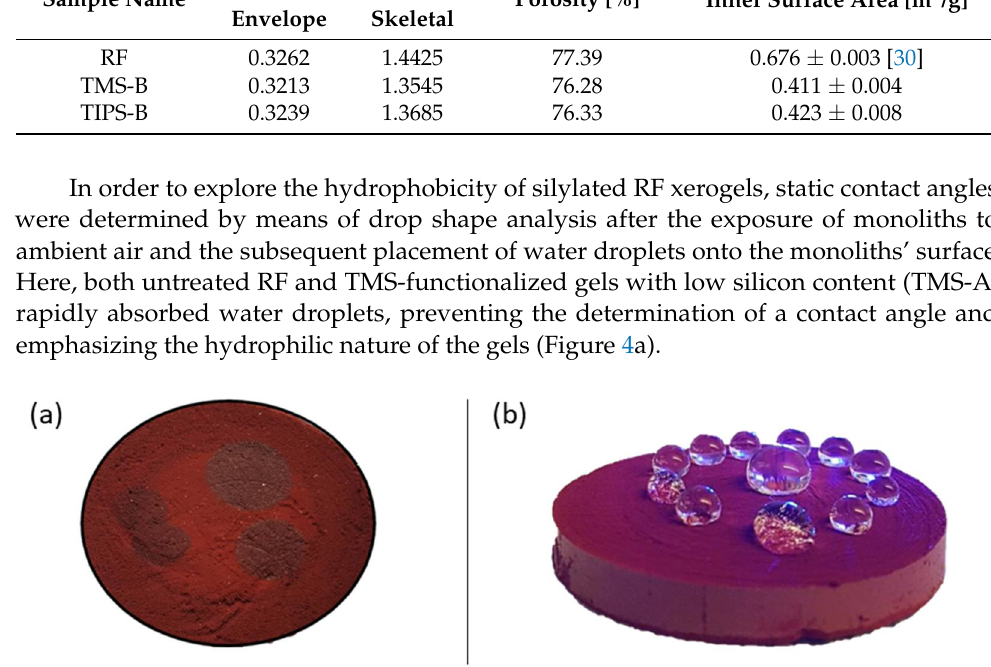
Table 2. Structural properties of unmodified and silylated RF gels.